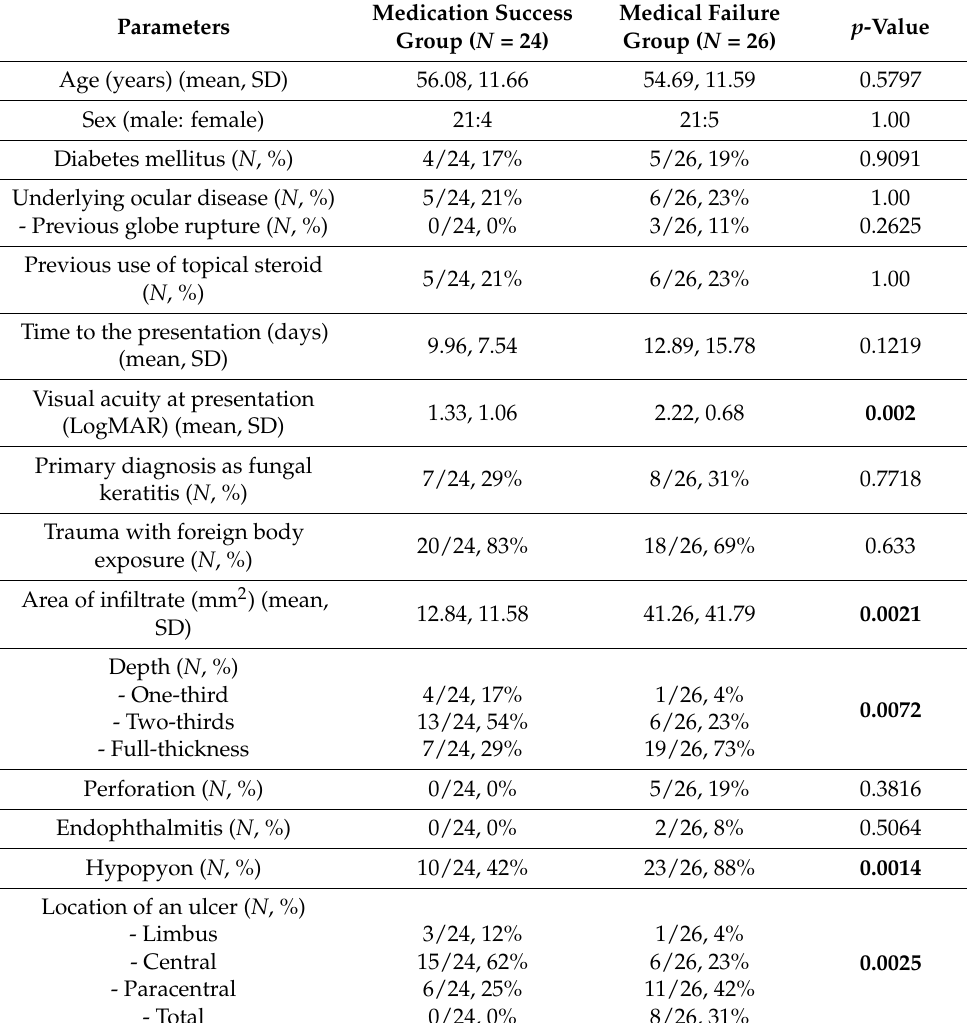
Table 6. The comparison of demographics and clinical characteristics between the medication success and failure